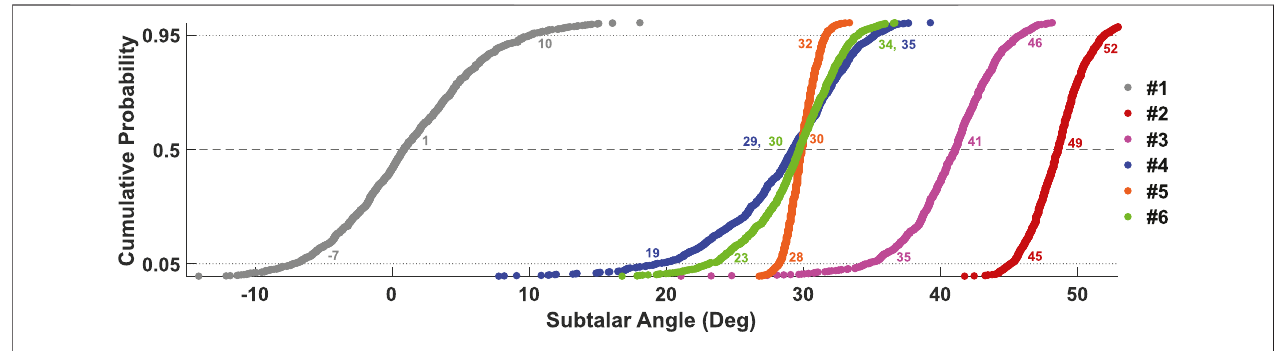
FIGURE4| Subtalarjointpeakangle(supination,+)inresponsetovariedintrinsicandextrinsicsprainparametersacrosssixMonteCarlosimulations(Study#1-#6, Table 1 ). Response values corresponding to the 5 th , 50th, and 95th percentile were extracted from cumulative distributions for comparison (horizontal dotted lines).